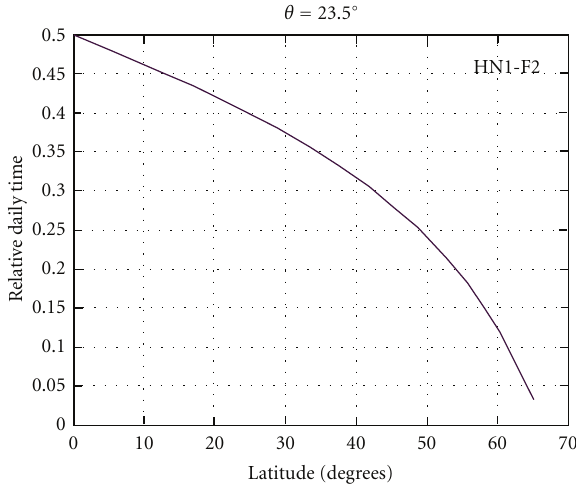
Figure 12: Relative daily light time relative to the Earth